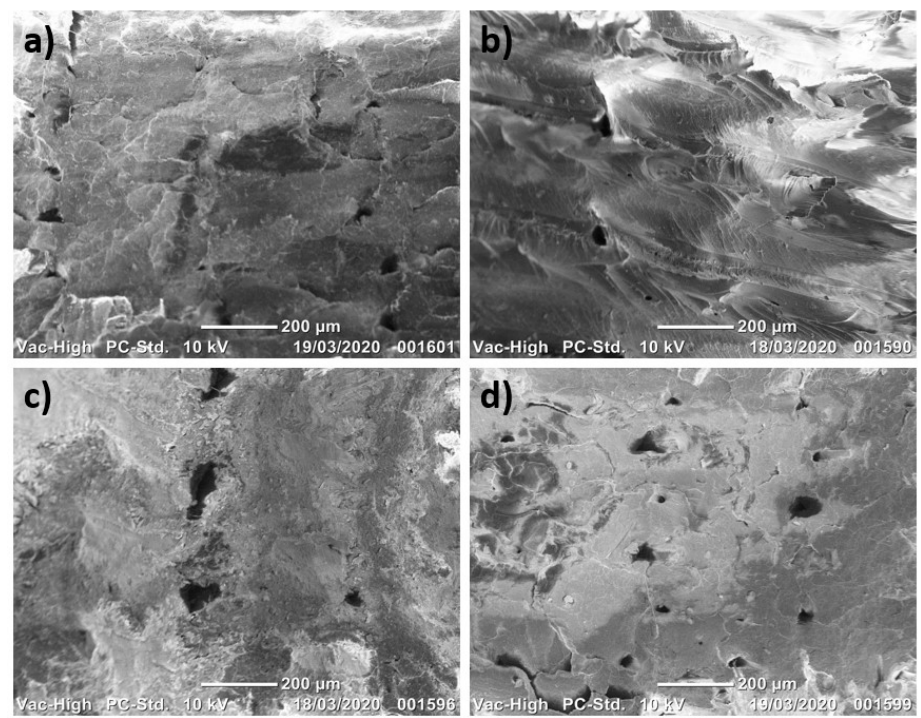
Figure 13. SEM micrographs for PLA material: ( a ) control PLA; ( b ) annealed at 70 °C; ( c ) annealed at 80 °C; ( d ) annealed at 90 °C.